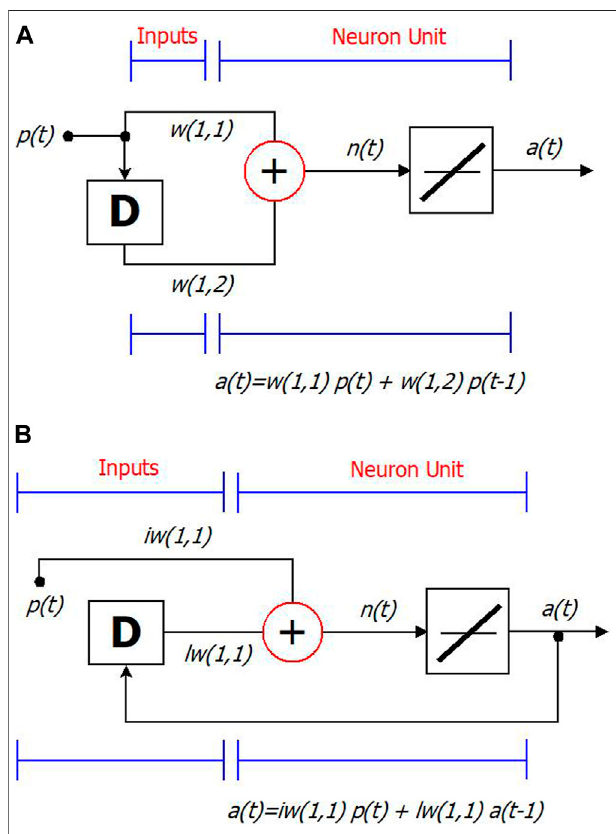
FIGURE 1 | Feed-forward dynamic neural net with single-delay, single- layer and single-neuron (A) , recurrent dynamic neural net with single-delay, single-layer and single-neuron (B)